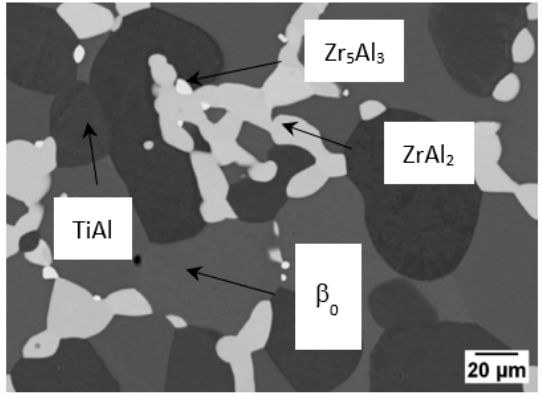
Figure 6. BSE micrograph of alloy Z4 (Ti-40.8Al-15.2Zr at. %) heat treated at 1100 °C/200 h showing